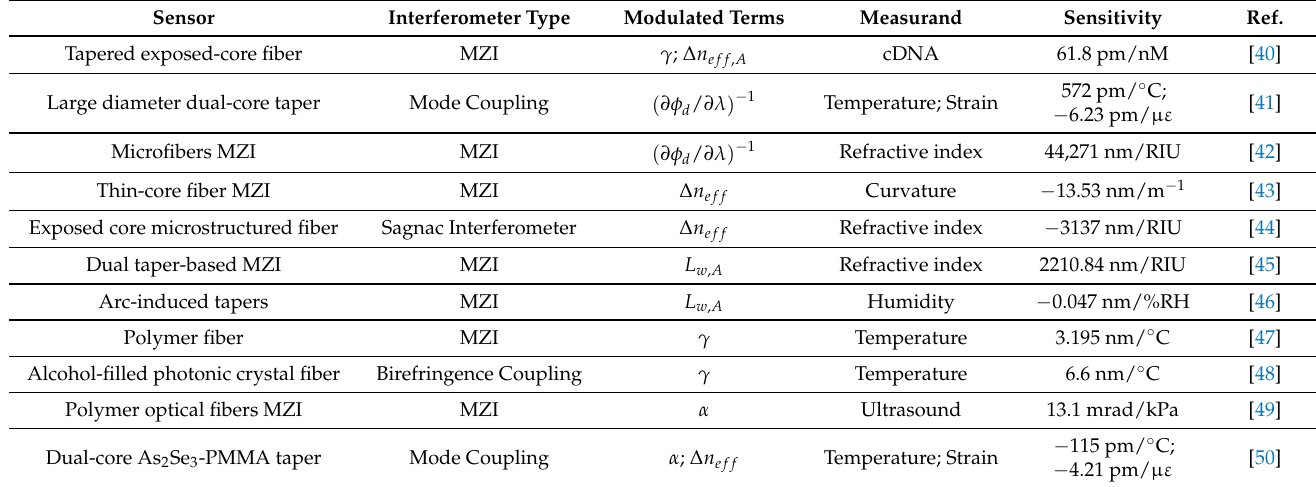
Table 1. The sensing characteristics of different interferometer-based